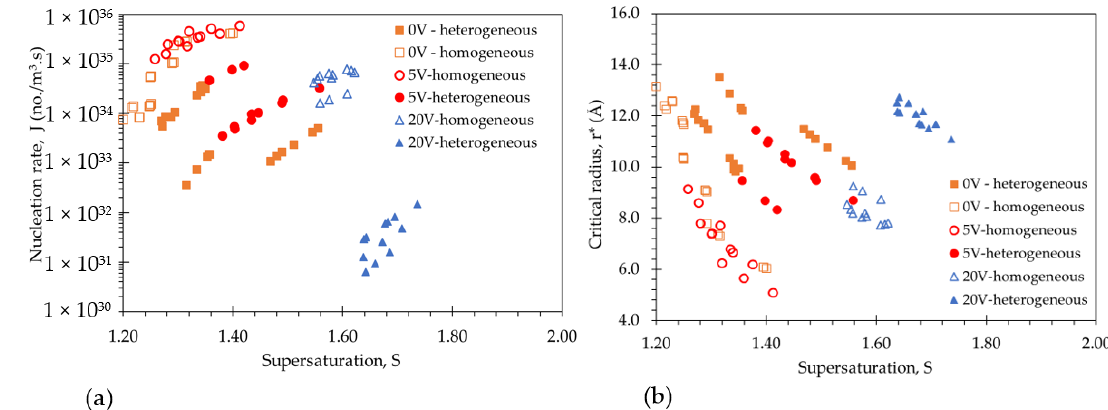
Fig 7 Figure 6. Nucleation parameters from isothermal nucleation due to variation in the electric potential applied to the solution. ( a ) Nucleation rate and ( b ) critical radius, r*, variations with supersaturation.